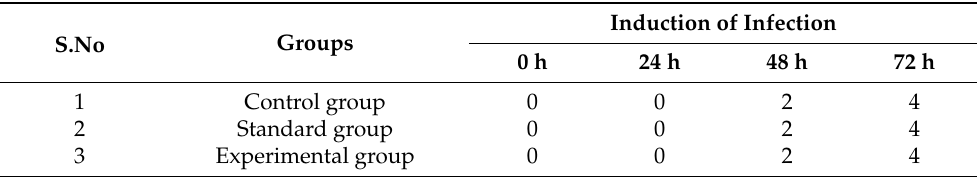
Table 7. Induction of infection in different groups of rabbits.